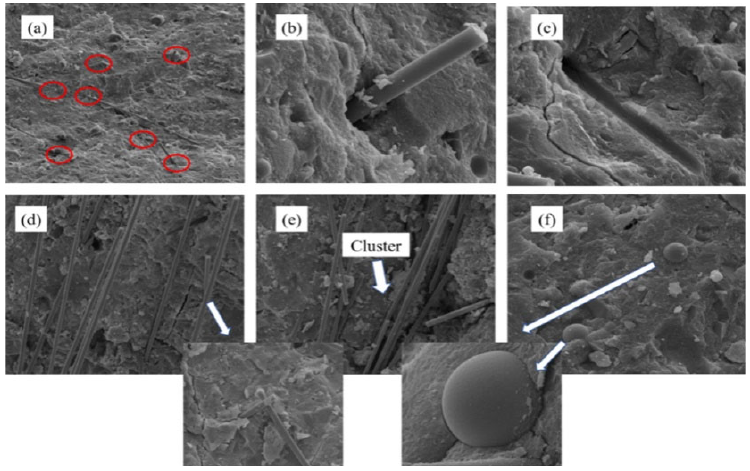
Figure 8. Morphology of CFRC at ( a – c ) low CF content and ( d – f ) high CF content [29]. Wang et al. [59] reported that CFs can obtain a uniform dispersion in the new disper- sant hydroxyethyl cellulose solution with the assistance of ultrasonic technology. A cer- tain amount of defoamer (Figure 2e) can e ff ectively reduce the bubbles in cement paste and improve its fl uidity. The compressive strength, tensile strength, and elastic modulus of CFRC prepared by this method are, respectively, 20%, 140%, and 26.8% higher than specimens without CFs. The mechanical properties of CFRC are well related to the inter- facial bonding strength between CFs and cement paste. Heo et al. [41,60] designed a unique treatment method that can uniformly coat nano-SiO 2 particles on the surface of CFs for hydrophilic modi fi cation based on the chemical reaction of a silane coupling agent. It was concluded that the signi fi cant improvement in the chemical binding force of the interface transition zone could be achieved through the C-S-H gel formed by the reac- tion of nano-SiO 2 and Ca (OH) 2. Furthermore, the CFRC modi fi ed by nano-SiO 2 coating increased the energy consumption during drawing failure, which contributed to the de- fl ection and blocking of crack di ff usion. Compared with ordinary mortar, the frictional bond strength and bending strength were increased by 27.3–33.0% and 58.1%, respec- tively. In contrast, the compressive strength decreased somewhat. This might have been caused by the air content introduced by the increased volume fraction of CFs [61]. Yet, Li